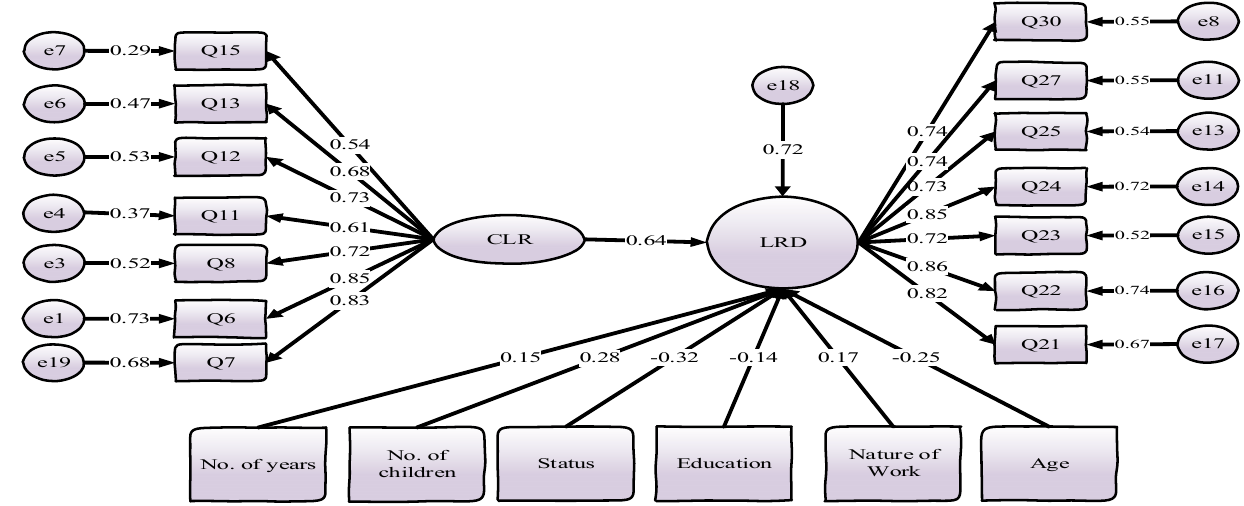
Figure 1. Testing the conceptual model. Table 6. Hypothesis testing.